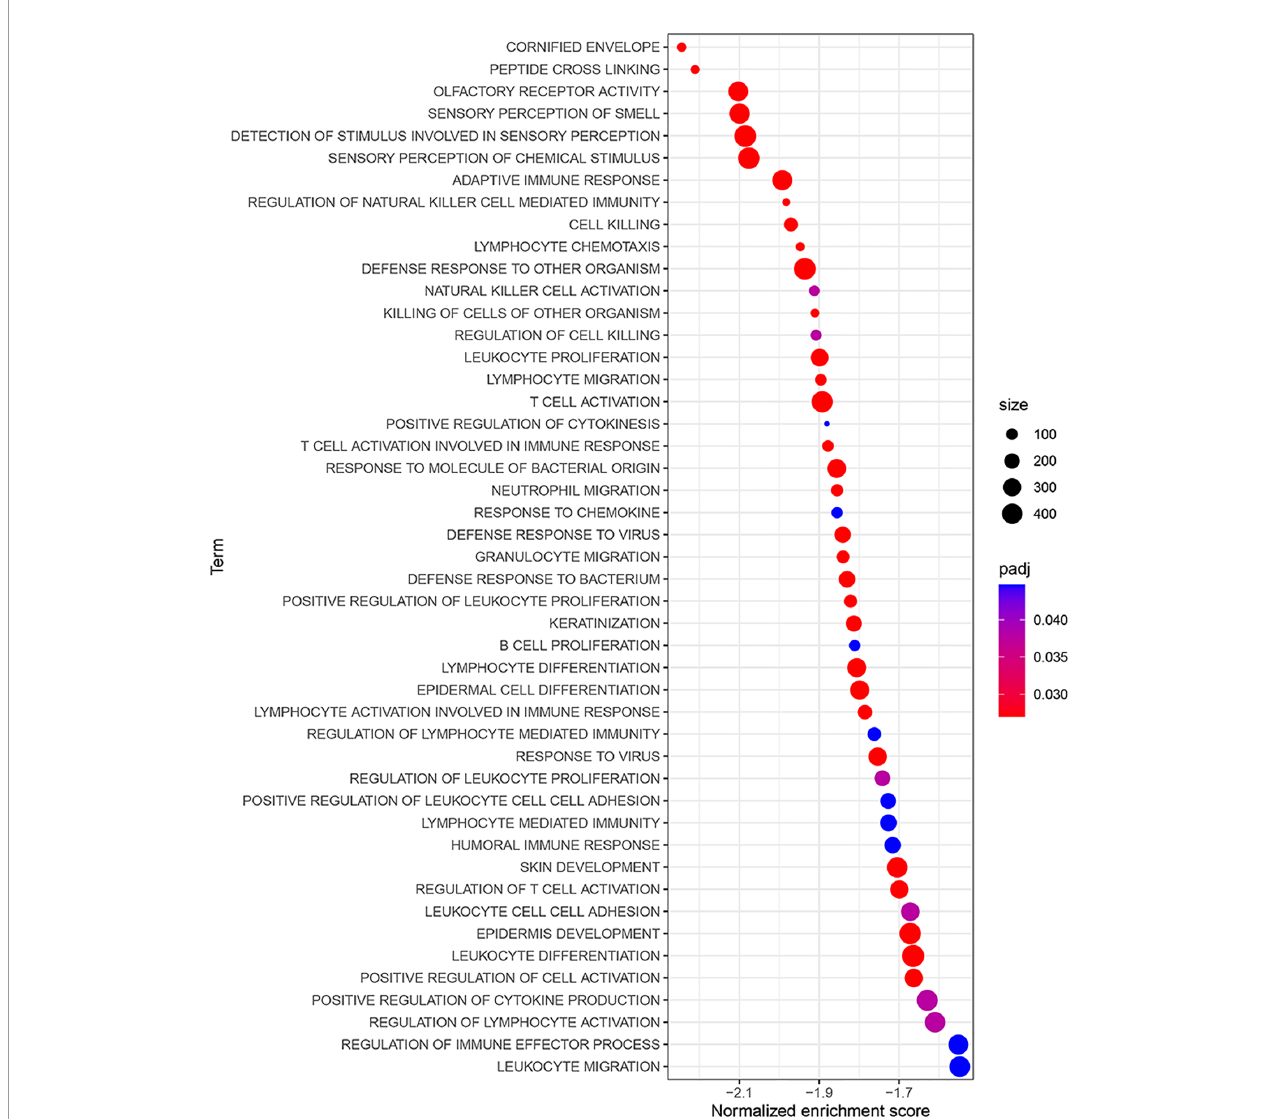
FIGURE 5 | GO-related GSEA between different risk groups. The NES was regarded as the primary statistic for examining GSEA enrichment results. GO, gene ontology; GSEA, gene set enrichment analysis; NES, normalized enrichment